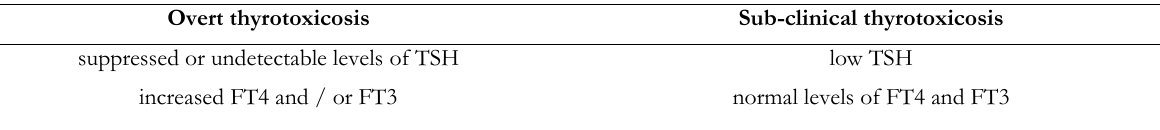
Table 3.1. Classification of thyrotoxicosis